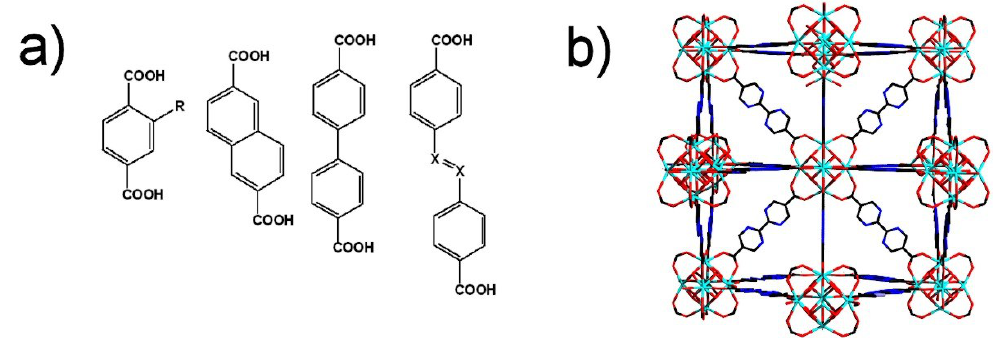
Figure 15. Structure of the organic linkers used in the MOF synthesis ( a ), and the structure of Zr-L 6 MOF ( b ). (Colour scheme: Zn, cyan; O, red; C, black; N, blue).